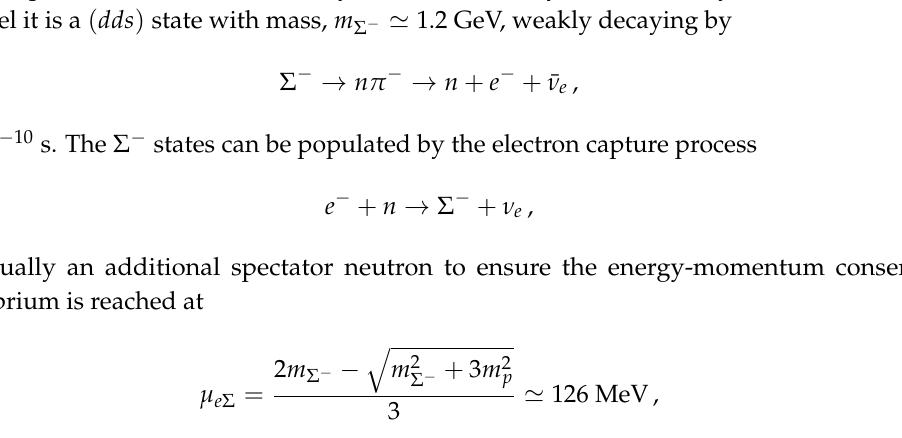
Figure 2. Sketch of the Pauli blocking mechanism for the charged pion decay (solid red line) induced by an increasing electron chemical potential. With increasing electron density, the electron chemical potential grows. The equilibrium configuration is reached for sufficiently high electron density, last figure on the right, with the pion decay process equilibrated by the electron decay process (blue dashed line), corresponding to µ e = m π